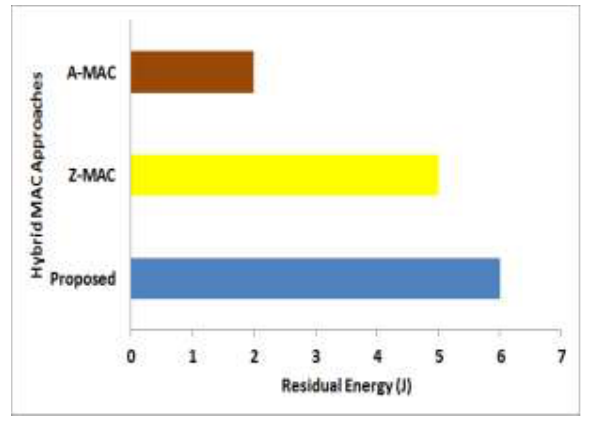
Figure 3. Comparative Analysis of Residual Energy.